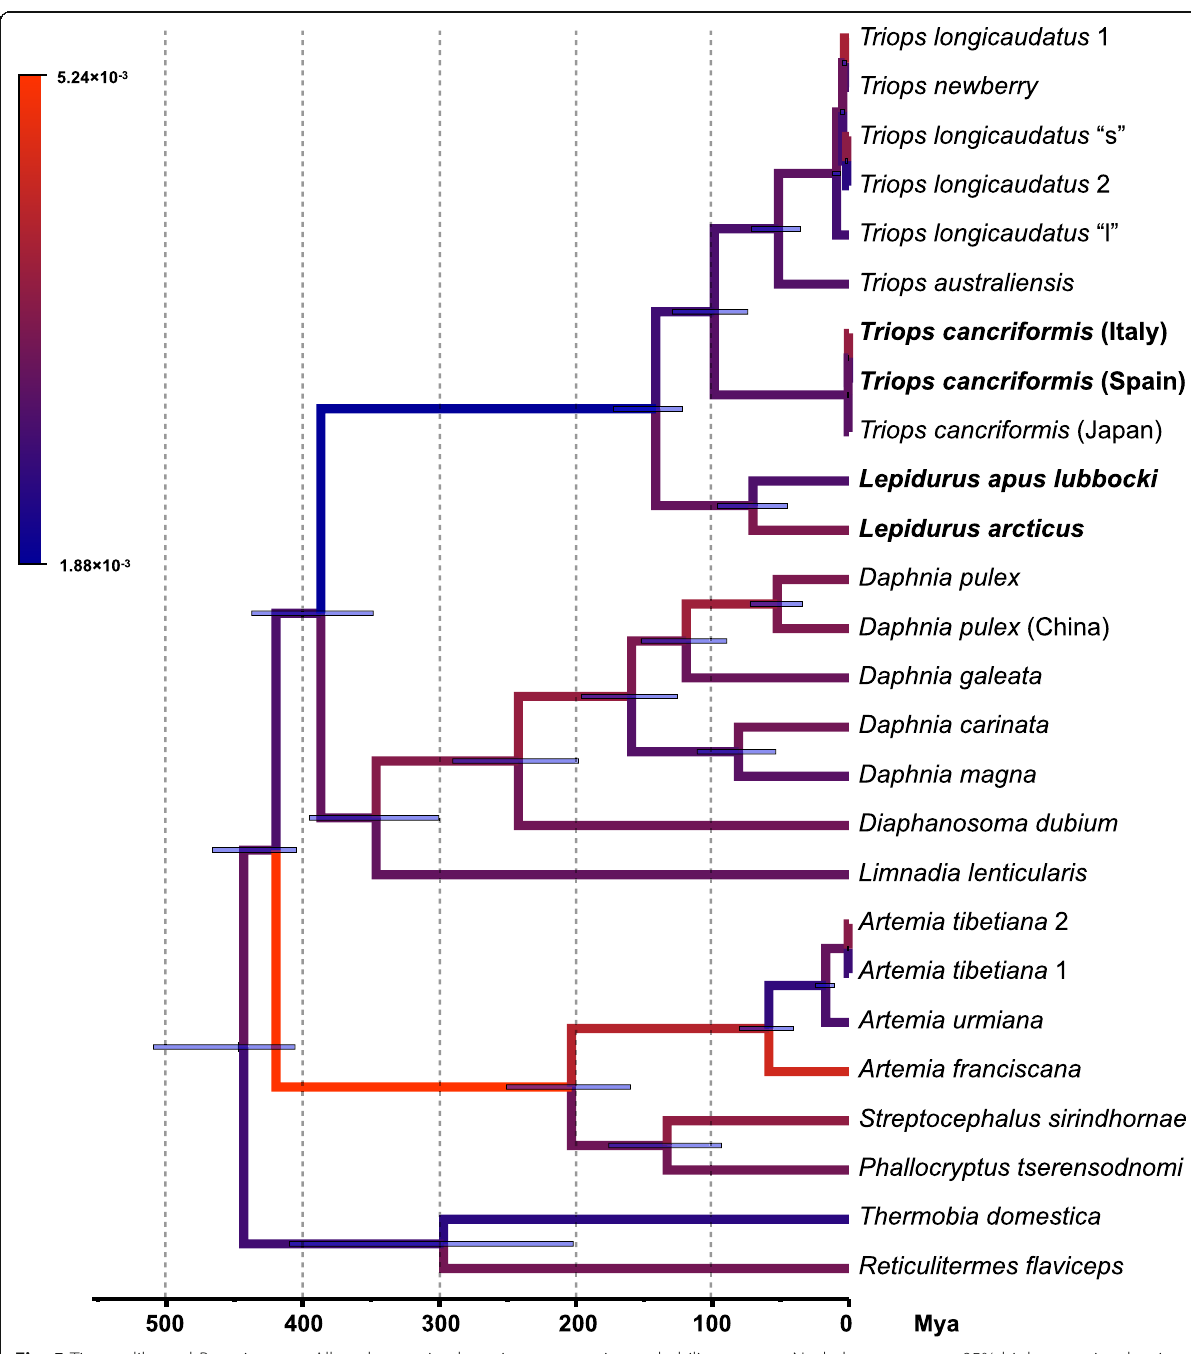
Fig. 5 Time calibrated Bayesian tree. All nodes received maximum posterior probability support. Node bars represent 95% high posterior density of age estimate. Branch colours vary accordingly to substitution rate (substitutions/site/million year), as indicated in the upper-left legend. Newly sequenced mitogenomes are indicated in